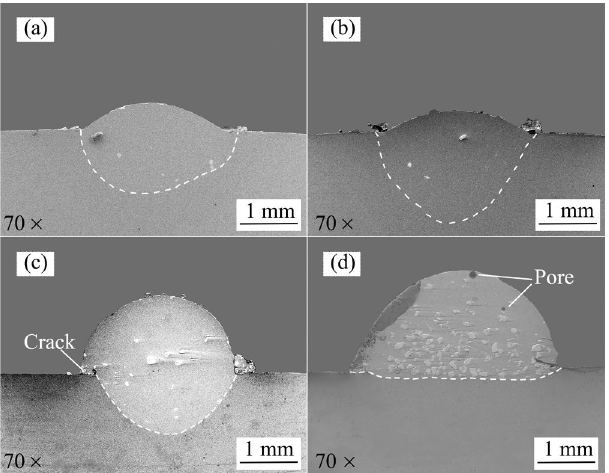
Figure 6. Cross-sectional morphologies of the Stellite 6/WC cladding layer: ( a ) S1; ( b ) S2; ( c ) S3; ( d )